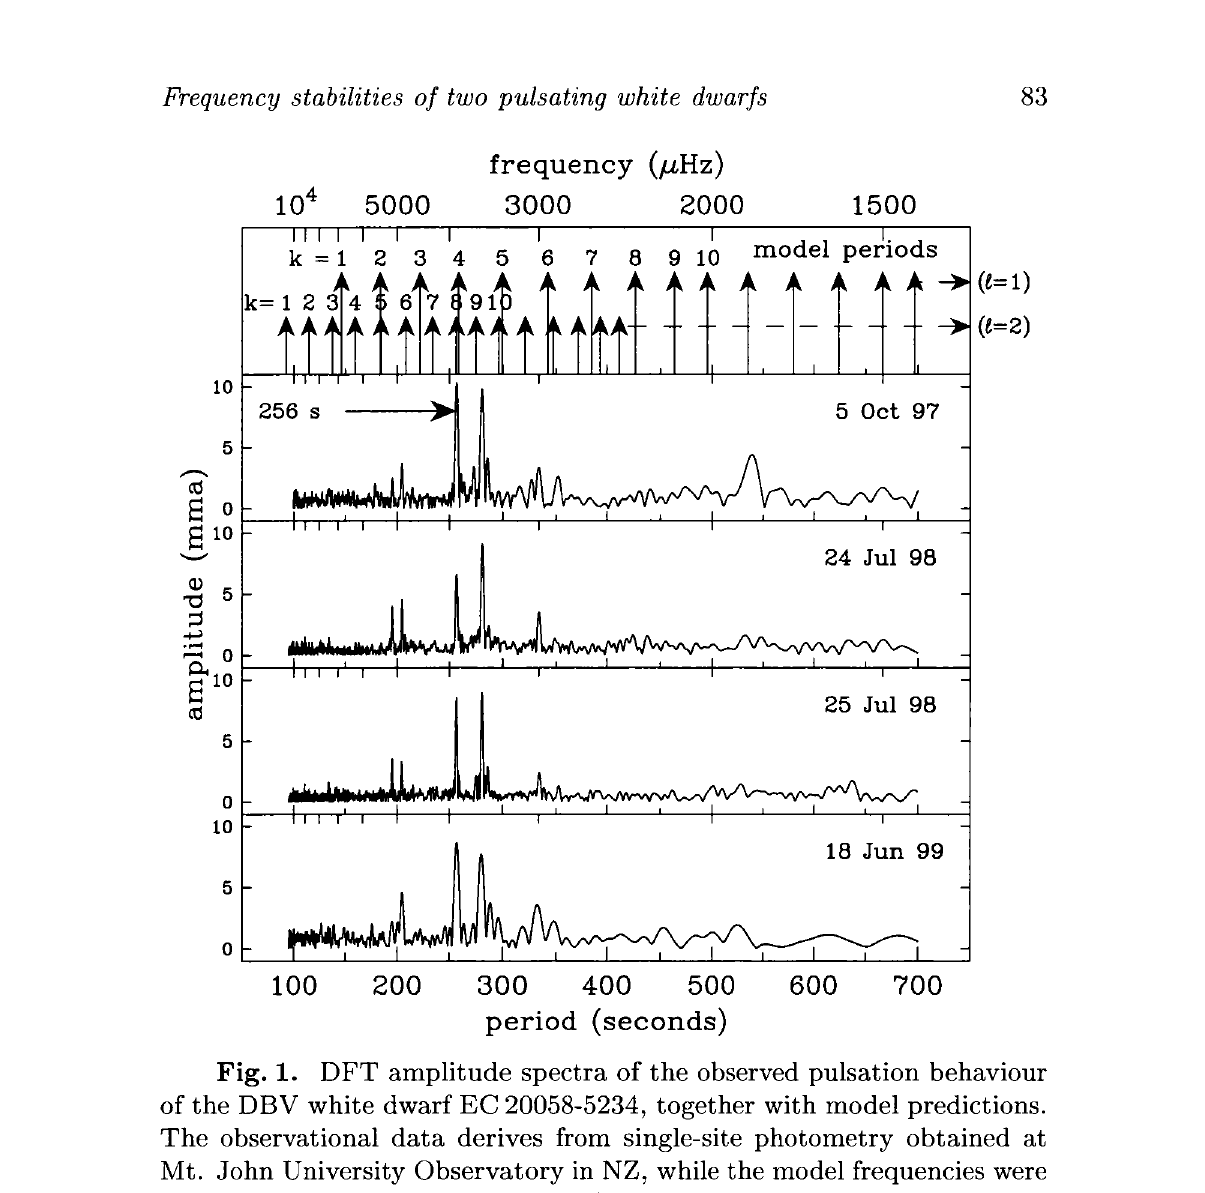
Fig. 1. DFT amplitude spectra of the observed pulsation behaviour of the DBV white dwarf EC 20058-5234, together with model predictions. The observational data derives from single-site photometry obtained at Mt. John University Observatory in NZ, while the model frequencies were obtained from the work of Bradley (1993,